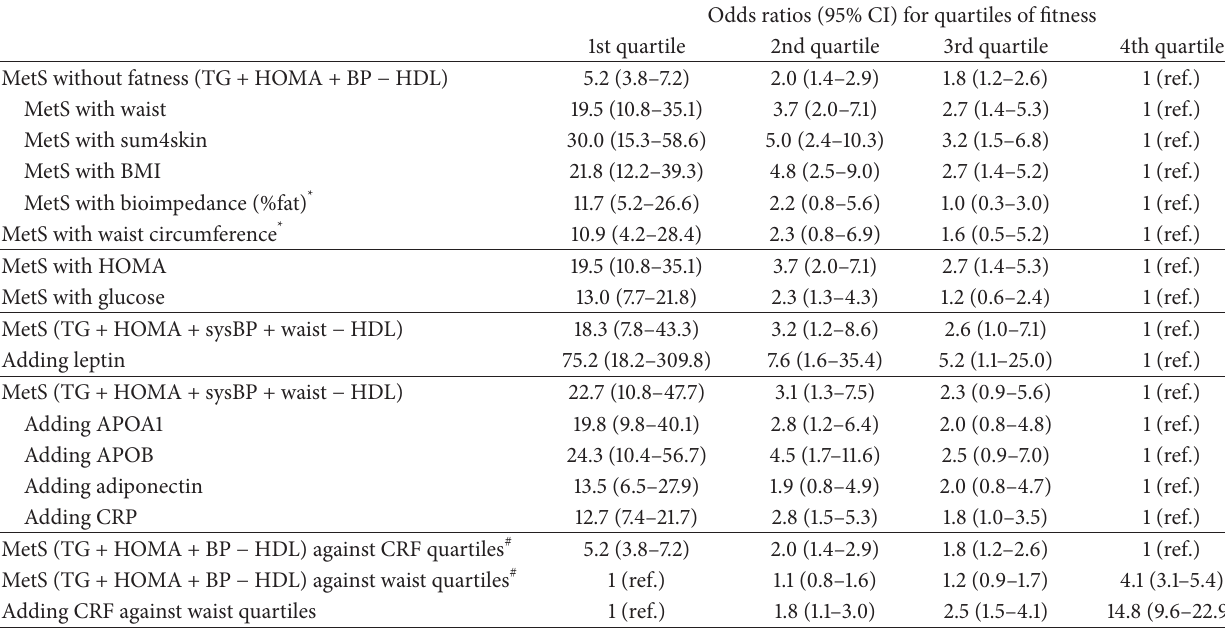
Table 4: Sensitivity analyses of changing one parameter in the MetS outcome with another covering the same trait. At the bottom CRF and waist circumference are compared against the same MetS outcome. For each comparison a cutoff point in 𝑧 -score was chosen, which selected the same proportion of